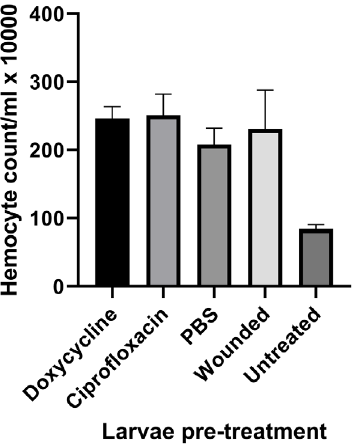
Figure 3. Hemocytes recovered from larvae pre-dosed with the antibiotic indicated, PBS or wounded with a syringe needle for three days prior to hemocyte recovery. The results shown are the average of four counts made on hemolymph extracted from groups of 10 larvae per treatment. Error bars =